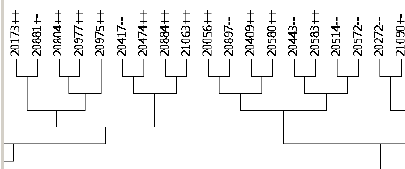
Figure 4: Part of the dendogram (using MEGA software [29]) for CPDBAS molecules. In the picture ’++’ indicates a drug with positive toxicity tests, ’–’ a drug with negative toxicity tests and ’+-’ a drug with some positive and some negative toxicity